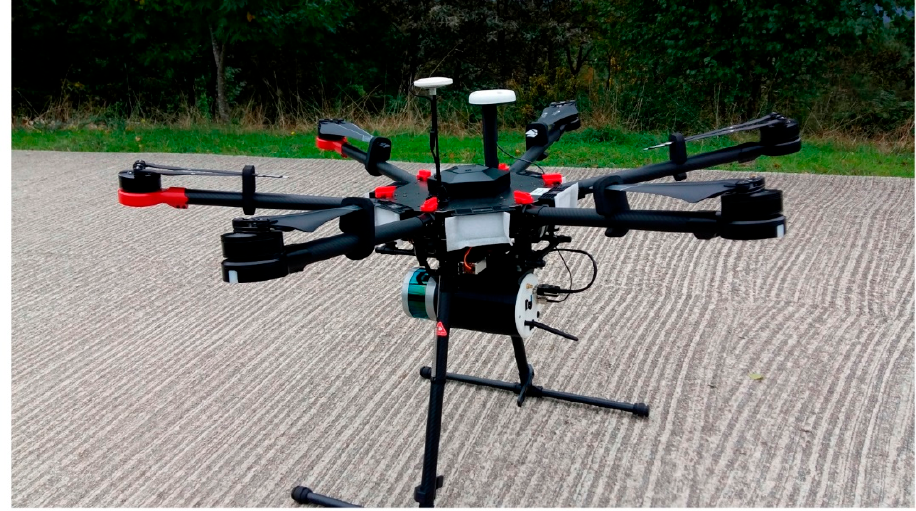
Figure 2. A typical ALS integrated into a drone [21].